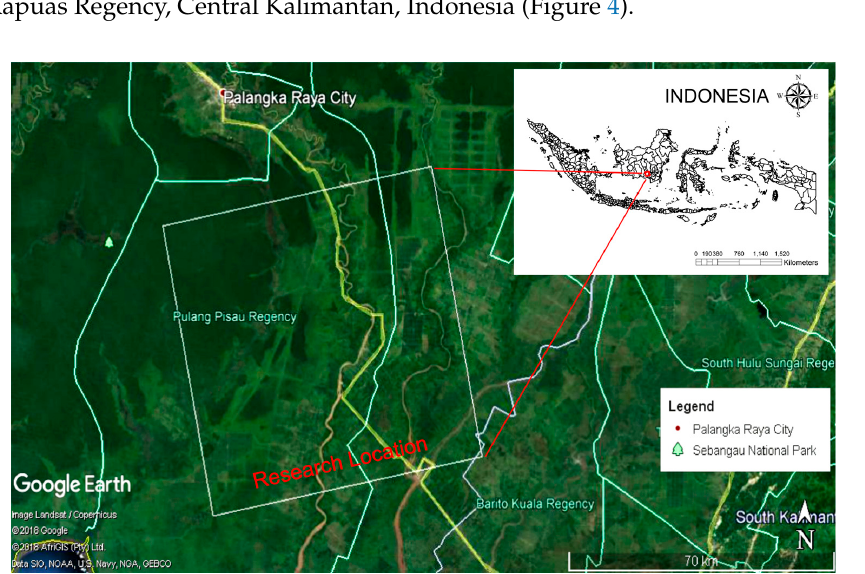
Figure 4. Research location in Pulang Pisau and Kapuas Regency, Central Kalimantan, Indonesia.